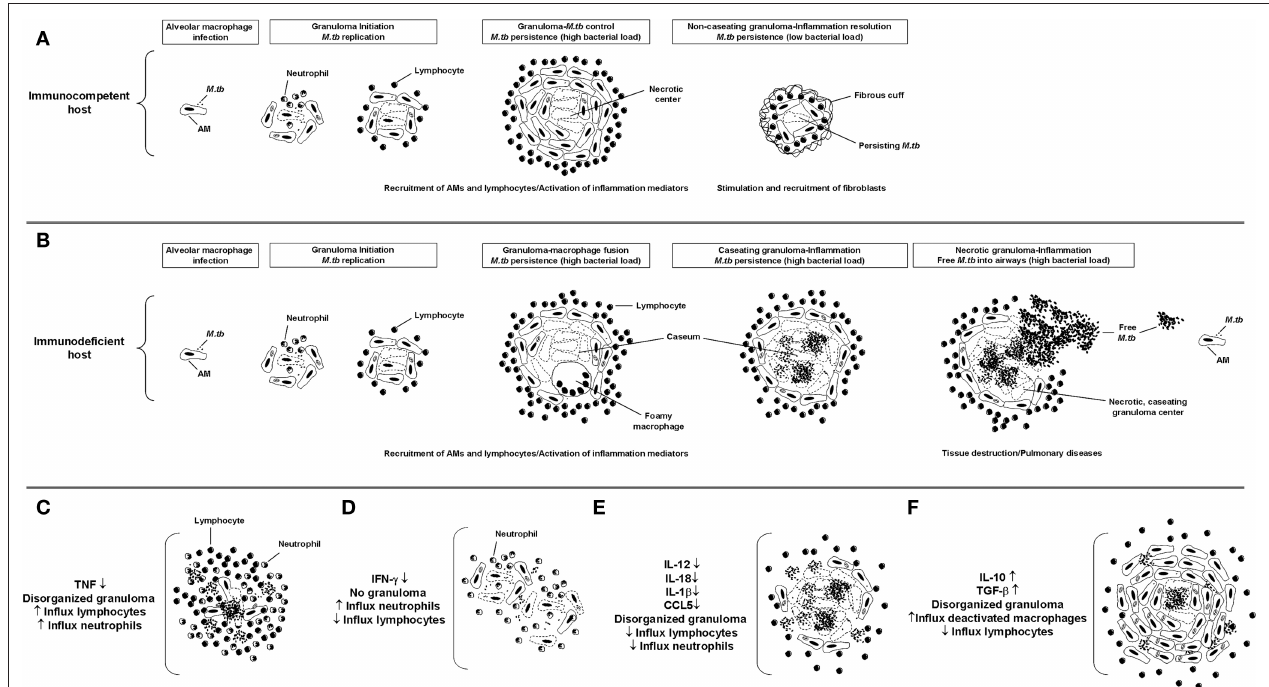
Figure 1 | granuloma formation. Schematics of lesion structure at each stage of granuloma formation in immunocompetent (A) or immunodeficient (B) M.tb -infected people. Once M.tb reaches the lungs, bacilli are internalized by AMs triggering the subsequent inflammatory response. In the early stage, the granuloma has a core of infected macrophages enclosed by mononuclear phagocytes, surrounded by lymphocytes. In the case of immunocompetent people, infection will be contained within small and compact granulomas